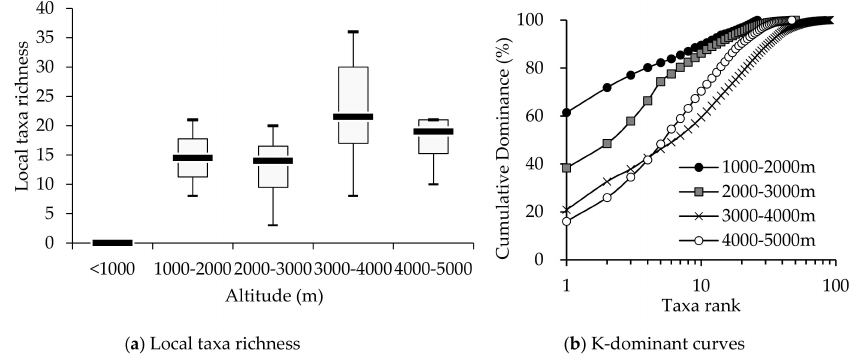
Figure 3. ( a ) Local taxa richness and ( b ) K-dominant curves of macroinvertebrate assemblages for the different altitude regions in the Yalutsangpo